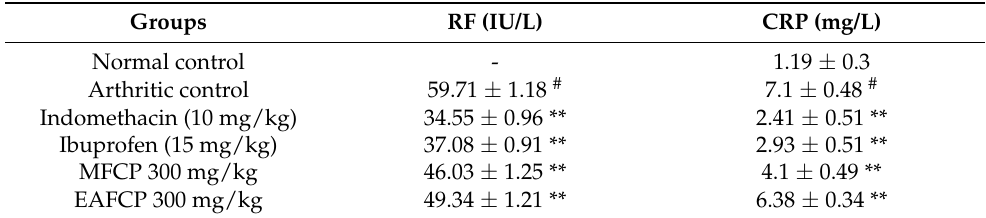
Table 5. Alterations in C-reactive protein (CRP) and rheumatoid factor (RF) in FCA-induced arthritis in rats.